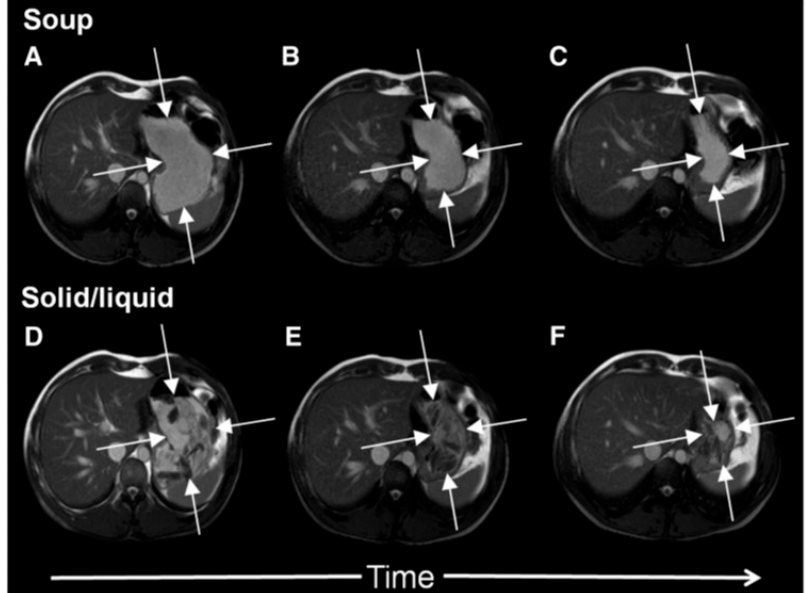
Figure 2. Cross-sectional MRI images showing a stomach at 0, 60 and 120 min after ingesting either roast chicken and vegetables (panels D, E and F respectively) or the same meal blenderised to create a homogeneous soup (panels A, B and C respectively). The solid meal taken with water appears heterogeneous, fluid can be preferentially emptied reducing gastric volume and hence the feeling of fullness. The same meal when blenderised appears homogeneous, gastric volumes fall more slowly with time which is associated with more prolonged satiety. Reproduced from [5], Oxford University Press 2012, with